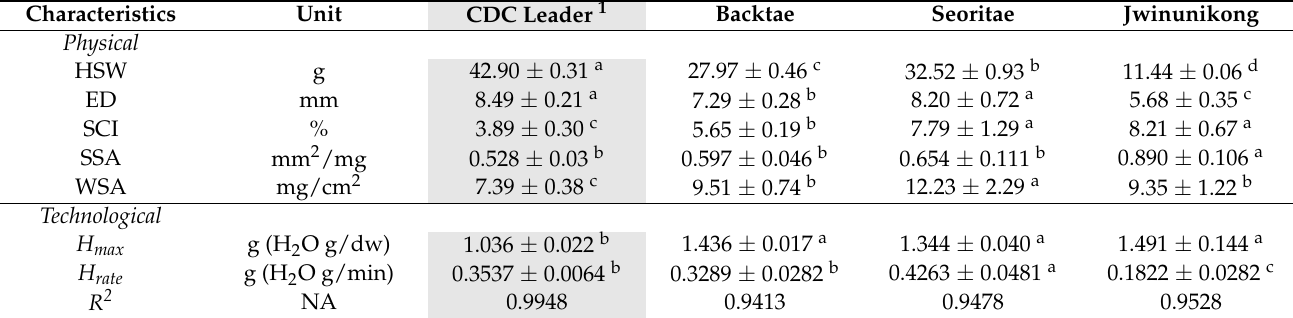
Table 2. Characteristics of the dried